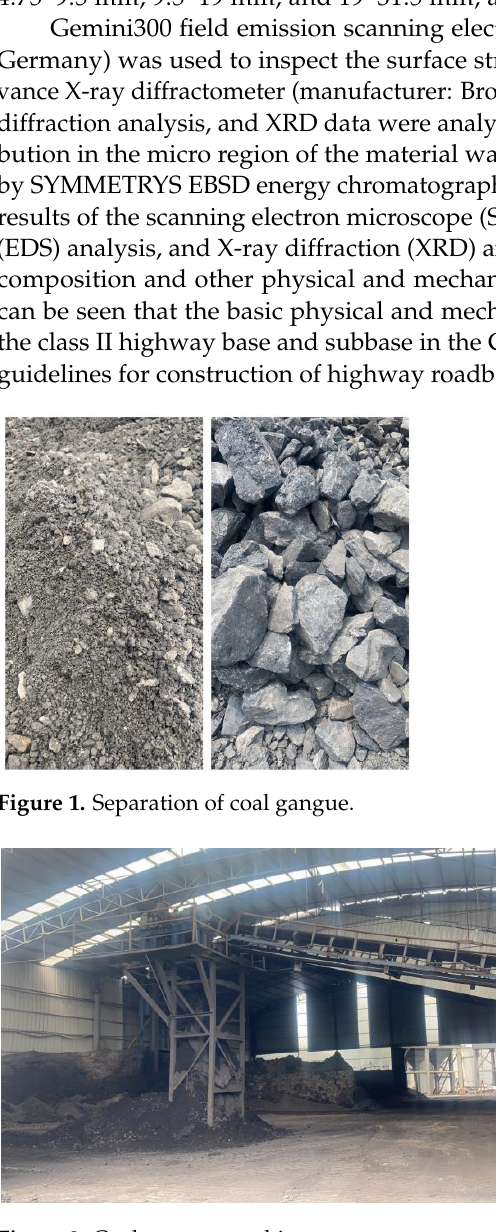
Figure 2. Coal gangue crushing.